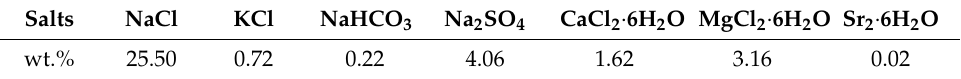
Table 2. Composition of synthetic sea water in a 1 L bottle.